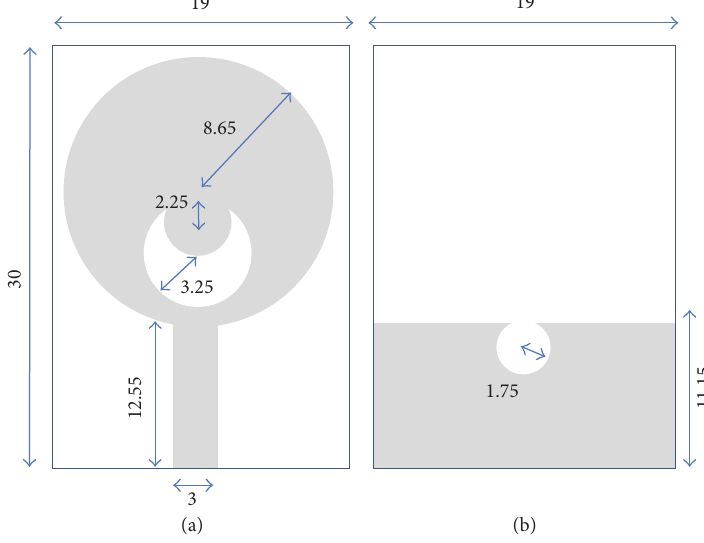
Figure 7: The final UWB antenna geometry. (a) Top view. (b) Bottom view.